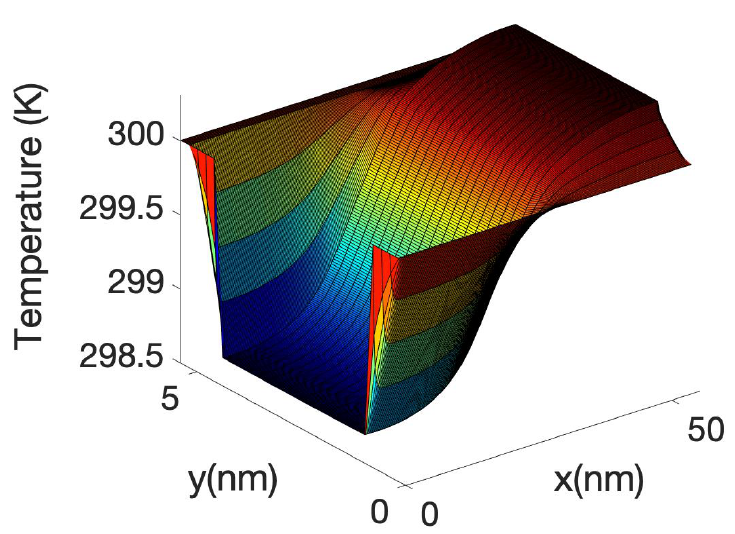
Figure 10. Temperature profile for (x,y) plane for the z coordinate located at the middle of wire cross section; for the coordinate system used and the device orientation see Figure 2. The profile corresponds to the hot electron self heating case (HSH) at a low bias of Vg = 0.3 V. The figure shows a slight cooling of the source of the transistor. The overall power dissipated inside the transistor is negative.